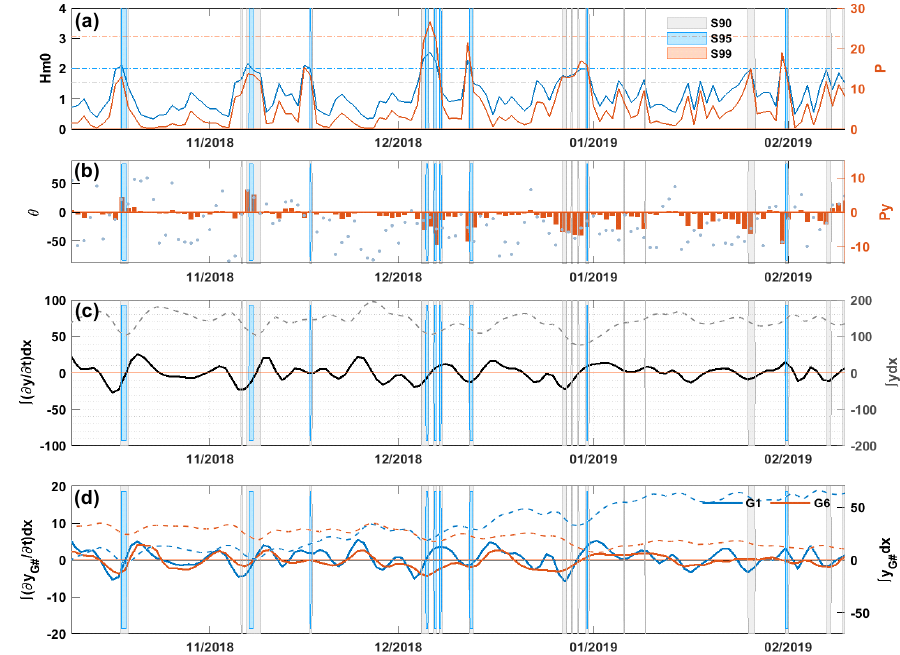
Figure 10. Changes in wave characteristics and beach width during the winter between 2018 and 2019. ( a ) Significant wave height and wave power, ( b ) wave direction and longshore component of wave power, ( c ) longshore transport rate (solid line) and integrated beach width (dashed line), and ( d ) longshore transport rate (solid line) and integrated beach width for sectors G1 and G6 (dashed line). The change of beach width represented by ∫ 𝑦𝑑𝑥 and ∫ 𝜕𝑦 𝜕𝑡⁄ 𝑑𝑥 during high-wave events is more conspicuous than that during periods of lower waves. During the winter between 2015 and 2016, as shown in Figure 7, a total of four S99 events were observed. The first two S99 events were